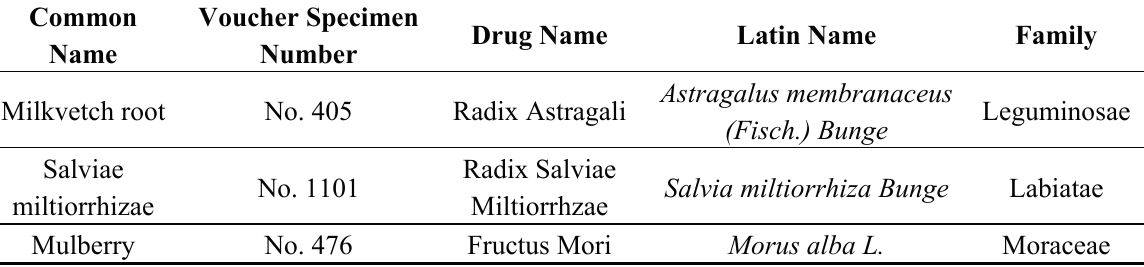
Table 1. The key ingredients in the extract of